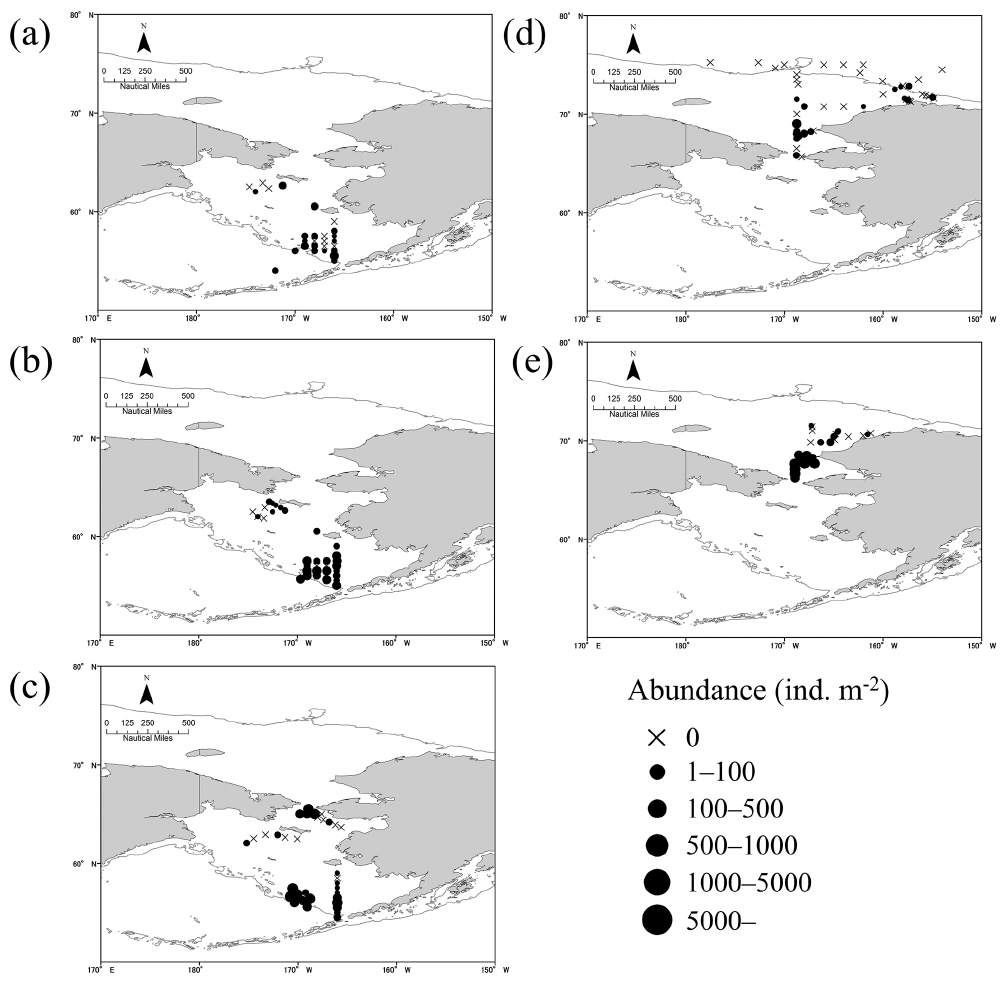
Figure 3. Densities (ind.m − 2 ) of krill in summer 2007 (a) , 2008 (b) , and 2013 (c) in the Bering Sea, and fall 2012 (d) and summer 2013 (e) in the Chukchi Sea. Solid gray lines indicate the 200m depth contours. Table 6. Relationship between the density of short-tailed shearwaters ( Ardenna tenuirostris , STSH; ind.km − 2 in each 50km 2 grid) and the size of krill in fall (September) 2012 and summer (June–July) 2013. Values are means ± SD with sample sizes in parentheses. The results of Mann–Whitney U tests are also